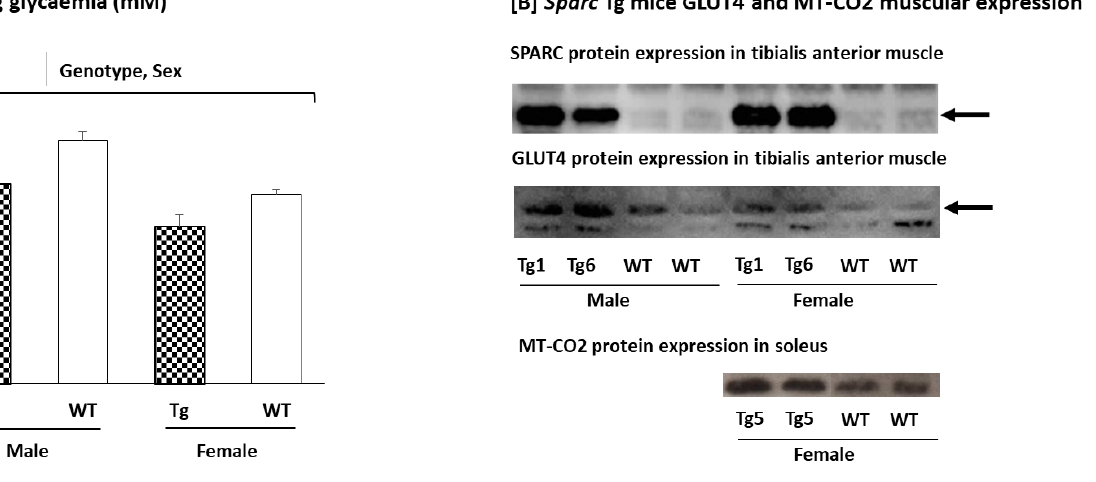
Figure 5. Glycemia as well as glucose transporter type 4 (GLUT4) and mitochondrially encoded cytochrome c oxidase II (MT-CO2) expressions in the muscle of F1 and F2 mice. As metabolic indicators, our measures showed that Sparc overexpression leads to a lower blood glucose ( A ) along with higher expressions of both GLUT4 and MT-CO2 ( B ). Glucose is lower in females compared to males as well ( A ). We also confirmed that SPARC is constantly overexpressed in Sparc Tg mice regardless of generation or sex ( B ). For the glycemia, all data are mean ± SEM, and the number of mice: 5 – 11 mice per experimental condition. Abbreviations: SPARC/ Sparc , secreted protein acidic and rich in cysteine; Tg, transgenic ( Sparc overexpression); WT, wild-type. Tg1: Sparc Tg line 1, Tg5: Sparc Tg line 5, Tg6: Sparc Tg line 6.